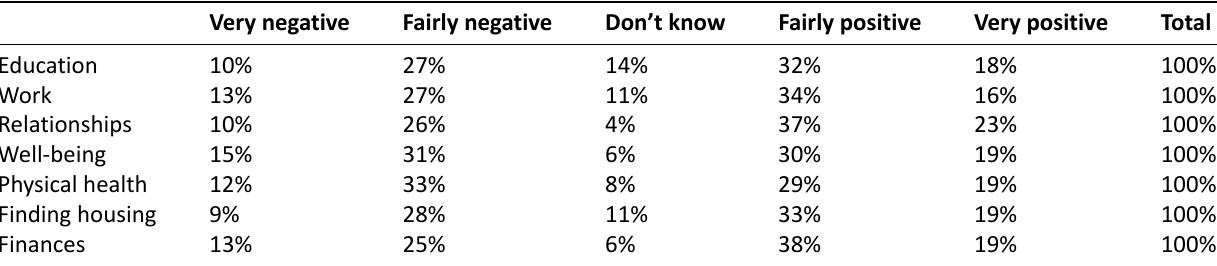
Table 7. Impact of sofa surfing on the situation of people aged 16–24 identified as sofa surfing during the year to September 2014.